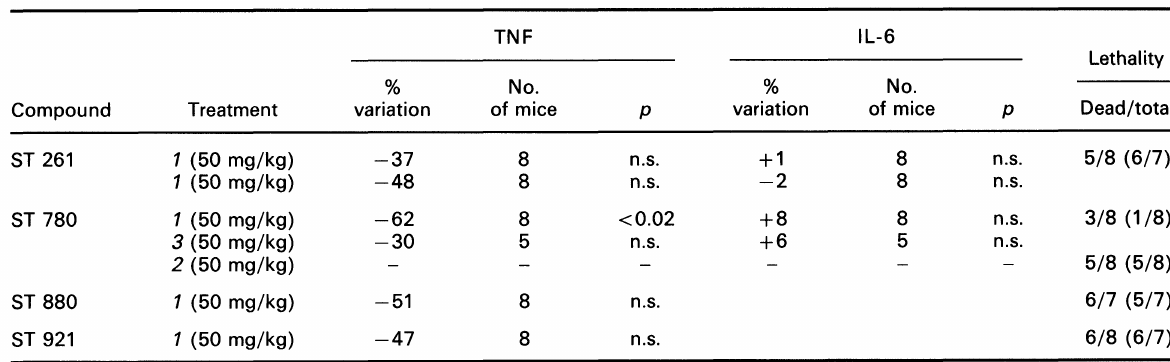
Table 4. Effects of propionyI-L-carnitine chloride (ST 261 and its derivatives (ST 780, ST 880, ST 921 on both serum TNF and L-6 production, and lethality of mice challenged with LPS